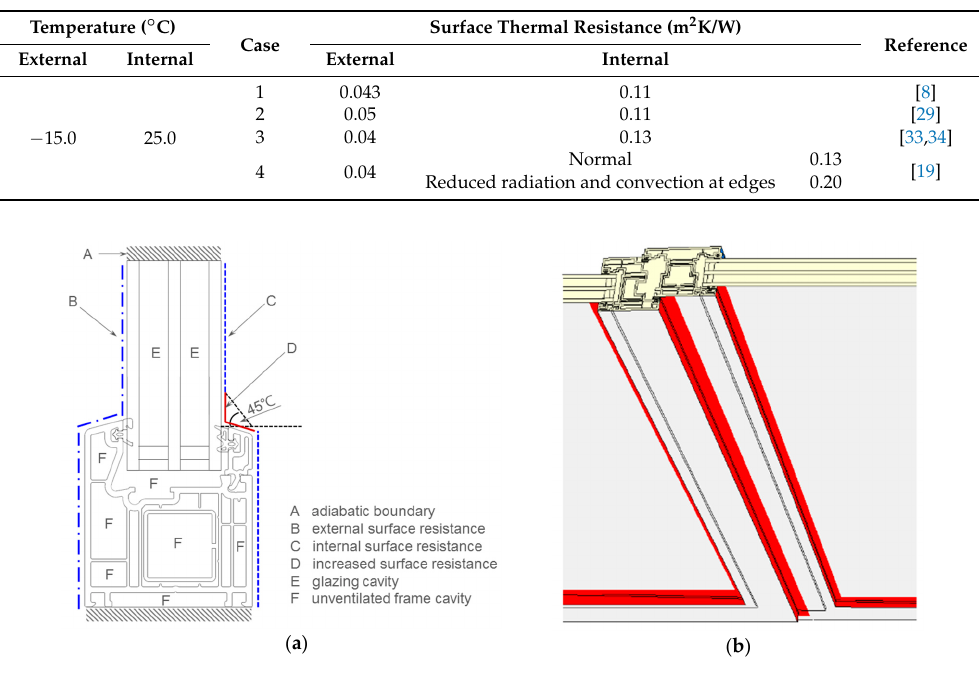
Figure 5. The treatment of the boundaries according to ISO 10077-2: ( a ) schematic of boundaries for Case 4; ( b ) shown in red are the local regions of increased surface resistance due to reduced radiation and convection. Table 2. Simulation cases and boundary conditions.